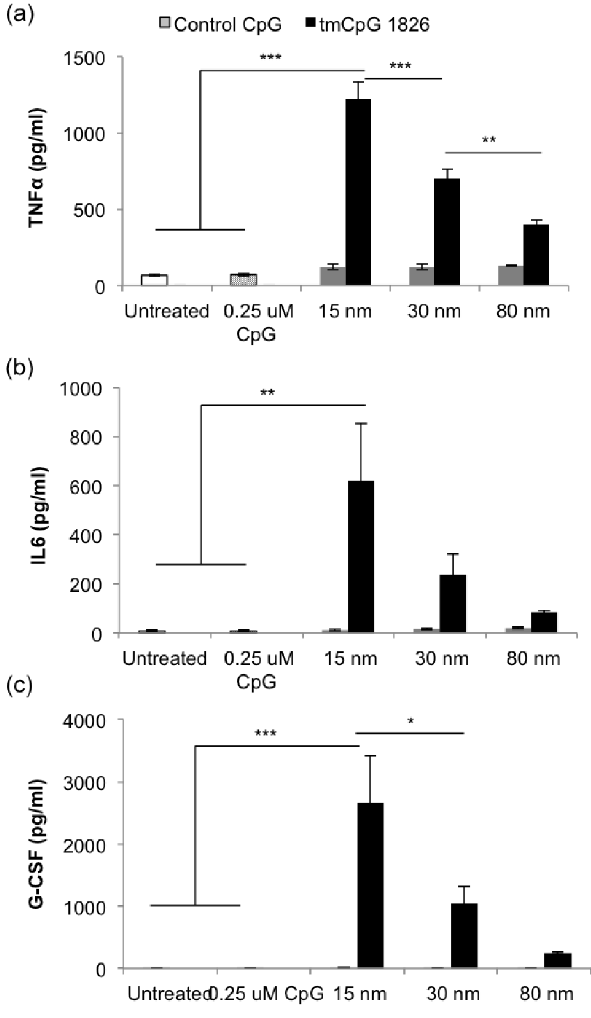
Figure 3. Cytokine and growth factor secretion following stimulation with free CpG, AuNPs coated with control tmCpG, or AuNPs coated with tmCpG for 15 nm, 30 nm and 80 nm core sizes. (a) TNF a secretion, (b) IL-6 secretion, and (c) G-CSF secretion (pg/ ml) (***p , 0.0001; **p , 0.01; *p , 0.05).